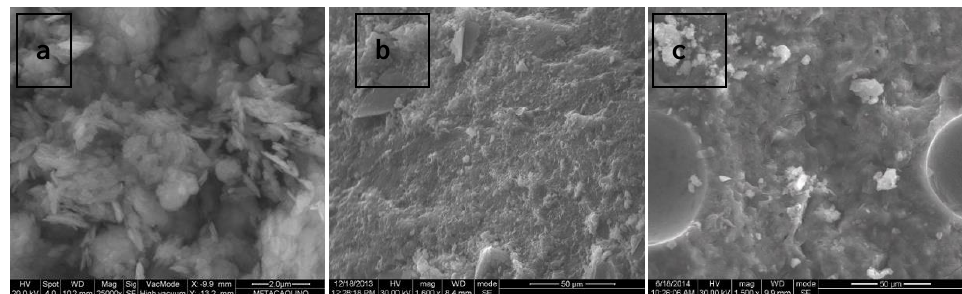
Figure 5 . SEM micrographs of ( a ) Metakaolin and geopolymeric mortars cured at 50 °C with ( b ) 0% wt FBA, and ( c ) 30% wt FBA